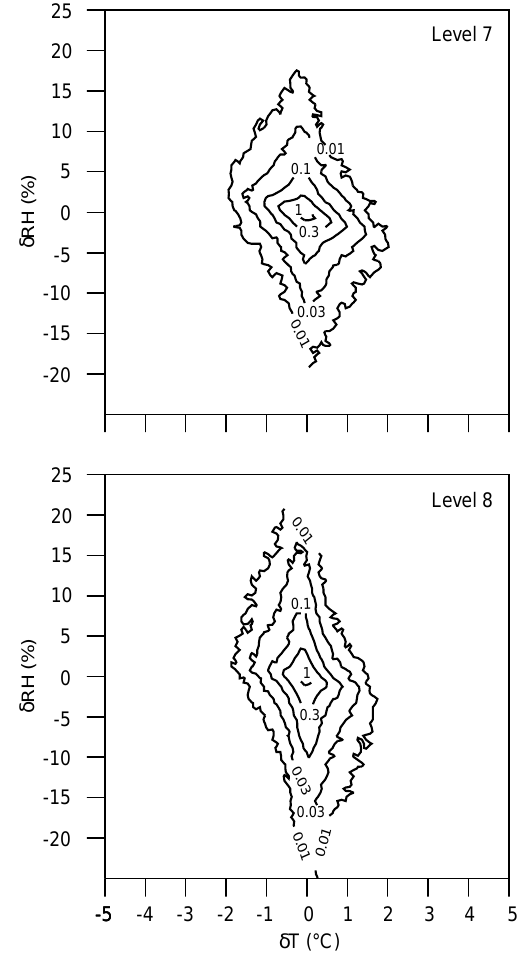
Fig. 7. Relative frequency of common fluctuations of relative humidity, (cid:100) RH , and temperature, (cid:100) T . This frequency distribution may be conceived an empirical jpd of common temperature and humidity fluctuations as obtained from the data from the MOZAIC data bank. The normalisation is as in